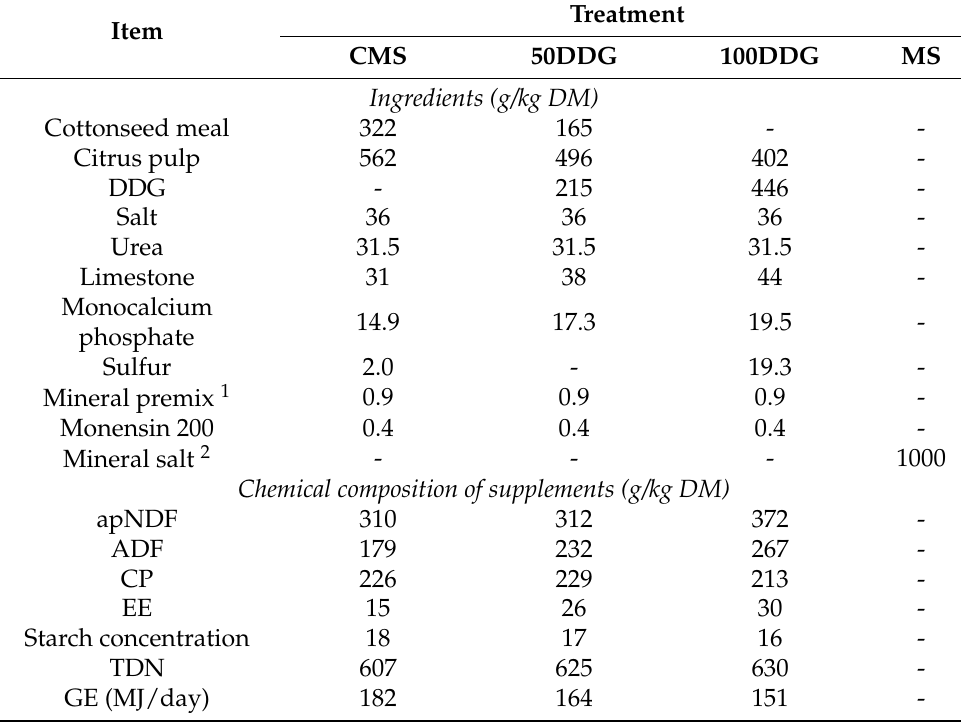
Table 1. Ingredients and chemical composition of the four supplement